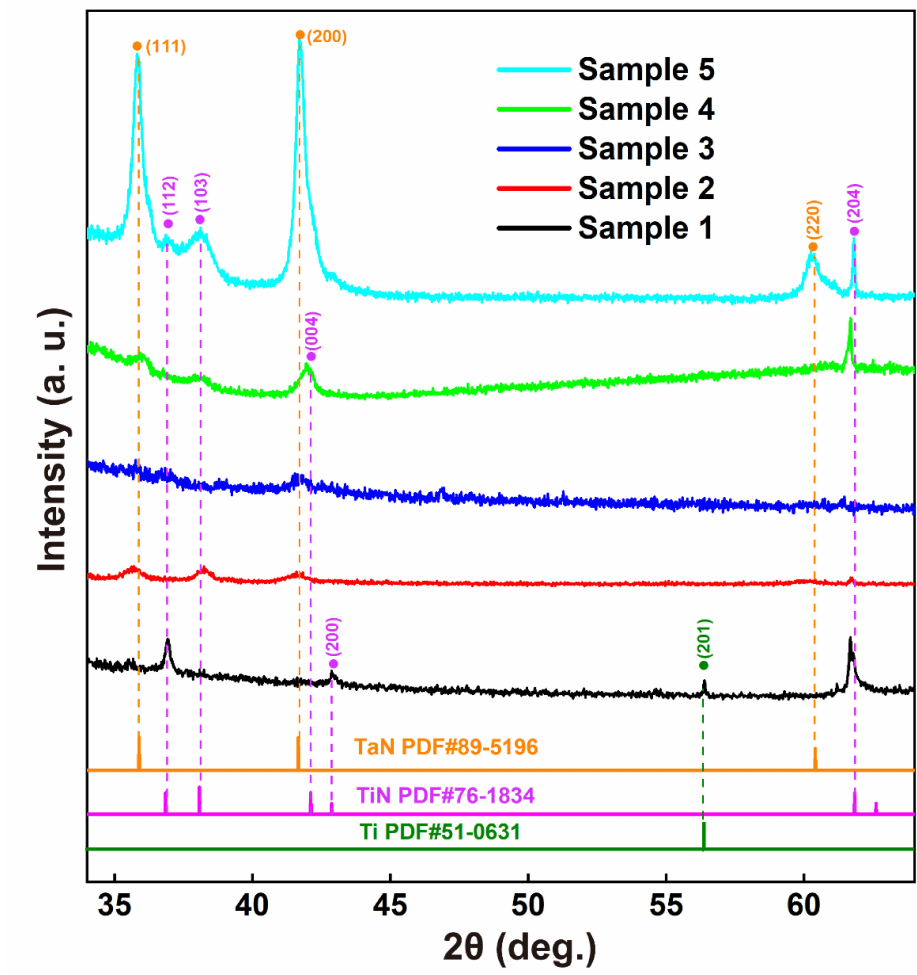
Figure 2. X-ray diffraction patterns recorded for the as-deposited TaN/(Ta,Ti)N/TiN/Ti coatings. The orange reference peak is TaN PDF#89-5196. The purple reference peak is TiN PDF#76-1934. The dark green reference peak is Ti